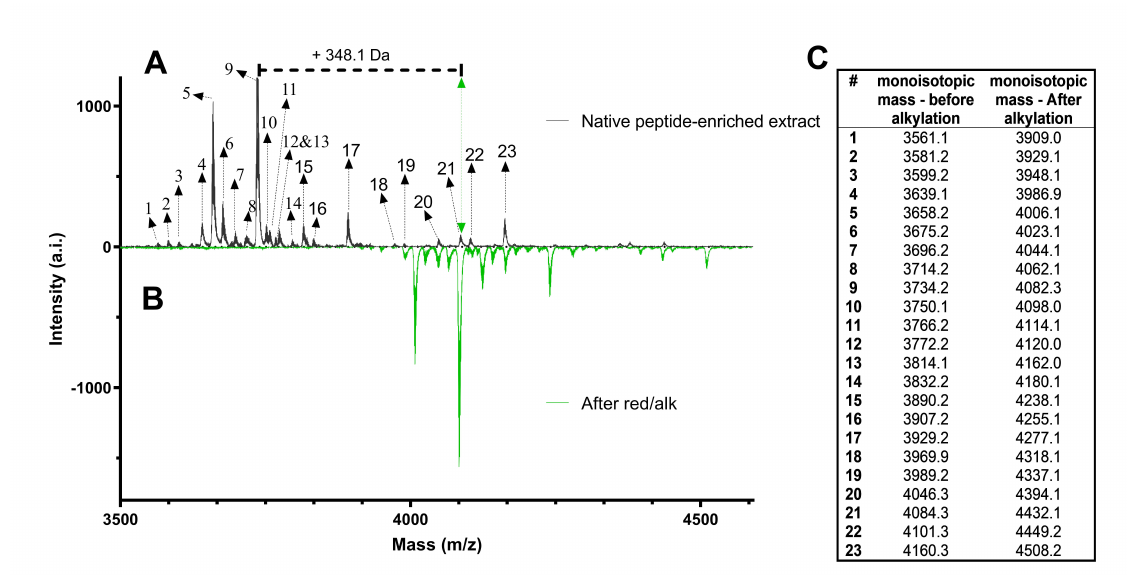
Figure 1. Chemical analysis of the citcol peptidome using matrix-assisted laser desorption ionization time-of-flight (MALDI-TOF) analysis. ( A ) The mass spectrum of a representative Citrullus colocynthis C 18 peptide-enriched extract is illustrated in the range of m / z 3500–4600 (black trace). Each black dotted arrow indicated by numbers (#) represents a cysteine-rich peptide (refer to Table in C). ( B ) Chemical modification of cysteine residues was performed by reduction and alkylation. A representative spectrum after S-carbamidomethylation is illustrated in green. The mass shift of ∆ 348 Da indicates the presence of six cysteine residues. For instance, the peptide signal at m / z 3734.2 shifts by 348.1 Da to m / z 4082.3. ( C ) List of monoisotopic mass signals [M + H] + of citcol peptides before and after